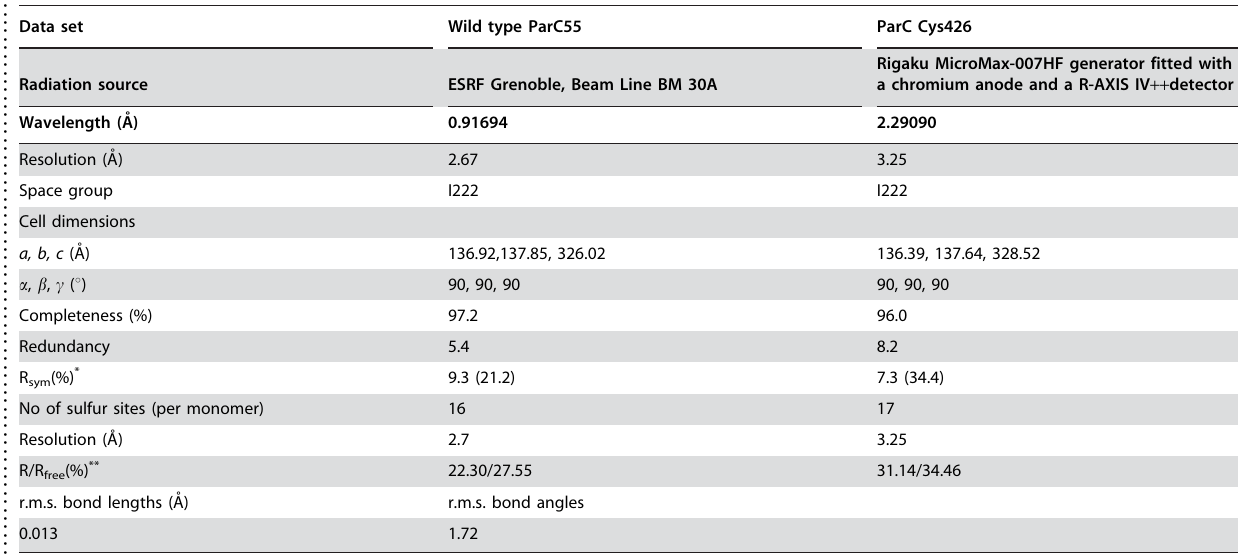
Table 1. Summary of the crystallographic analysis .. ... .... ... ... .... ... ... .... ... ... .... ... ... .... ... ... .... ... ... .... ... ... .... ... ... .... ... ... .... ... ... .... ... ... .... ... ... .... ... ... .... ... ... .